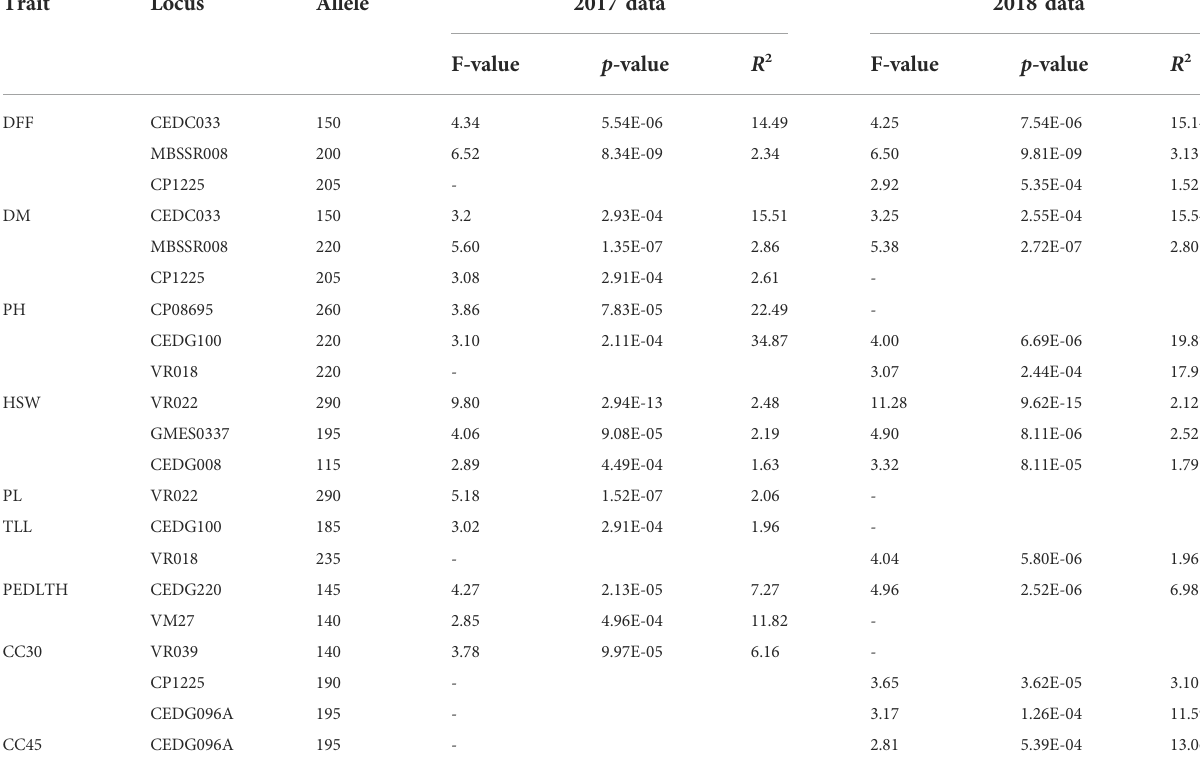
TABLE 2 Signi fi cant marker – trait associations identi fi ed from the MLM (Q + K) approach in different environments. Trait